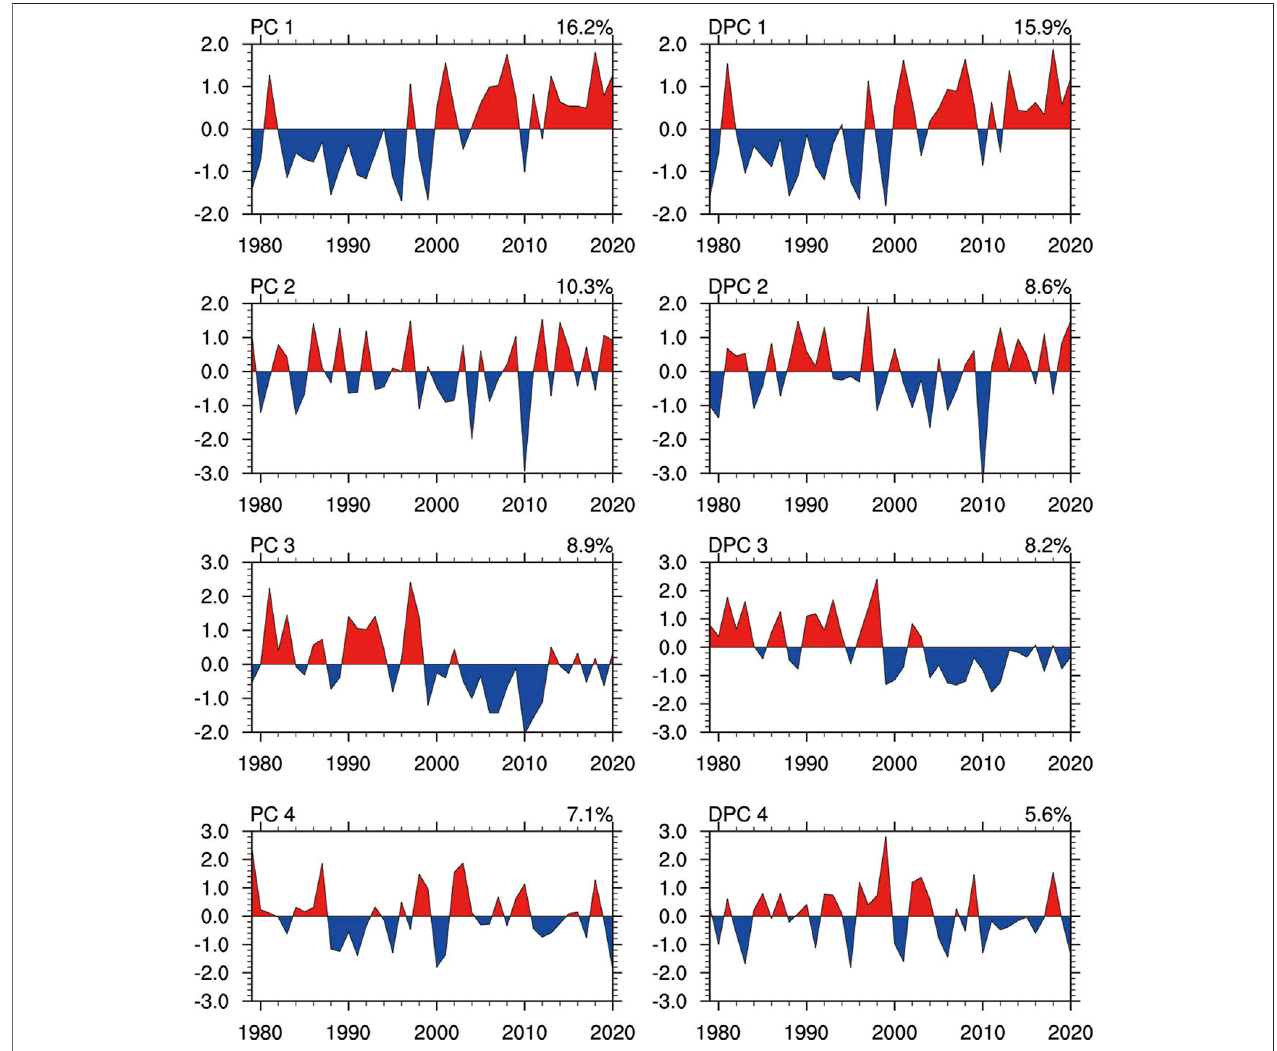
FIGURE4| TimeseriescorrespondingtothemodesofEOF(left-handpanel)andDEOF(right-handpanel)analysesforthespring 〈 Q 1 〉 intheQTPandsurrounding areas during the time period 1979 – 2020.